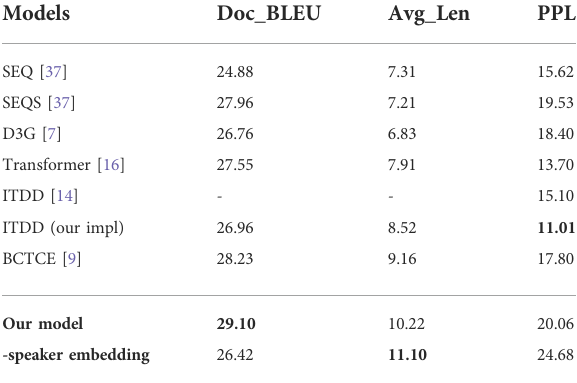
TABLE 4 Document relevance and response quality for baselines and the proposed model. The “ -speaker embedding ” indicates the speaker embedding is removed from the multi-view embedding module of our